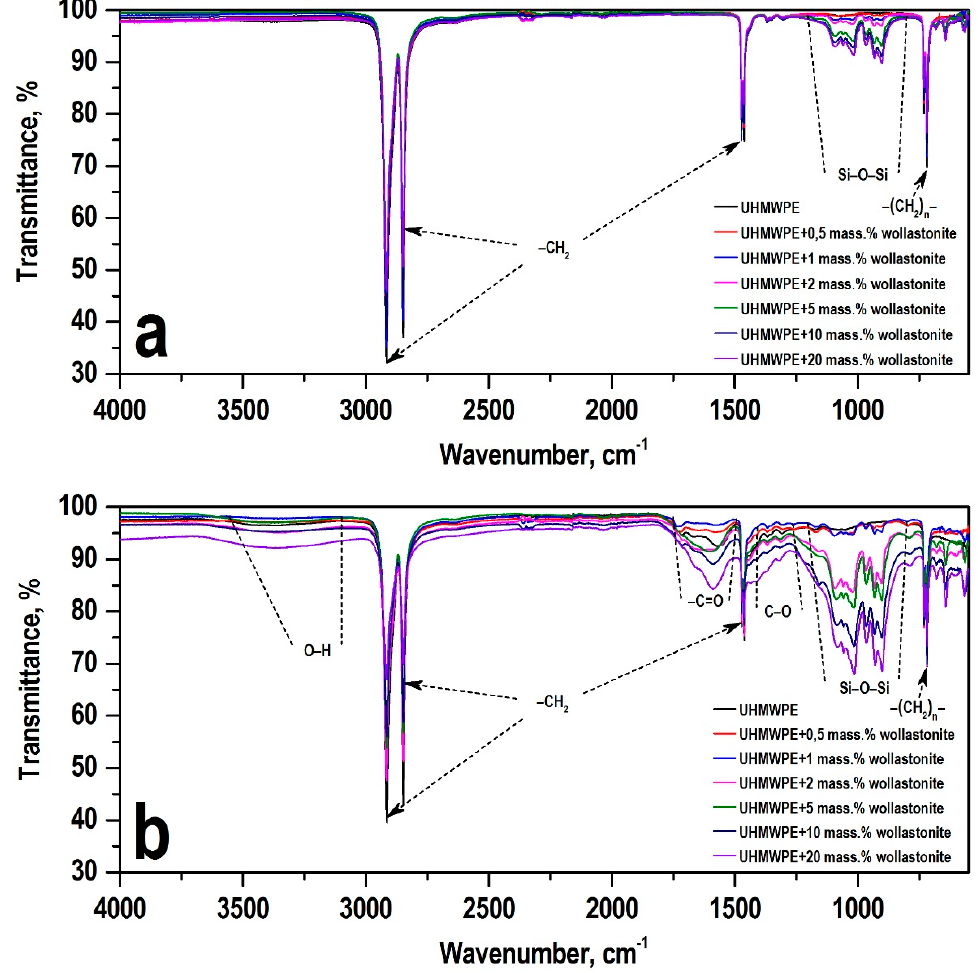
Figure 9. IR spectra ( a ) before friction and ( b ) after friction of PCM based on UHMWPE depending on the wollastonite content.